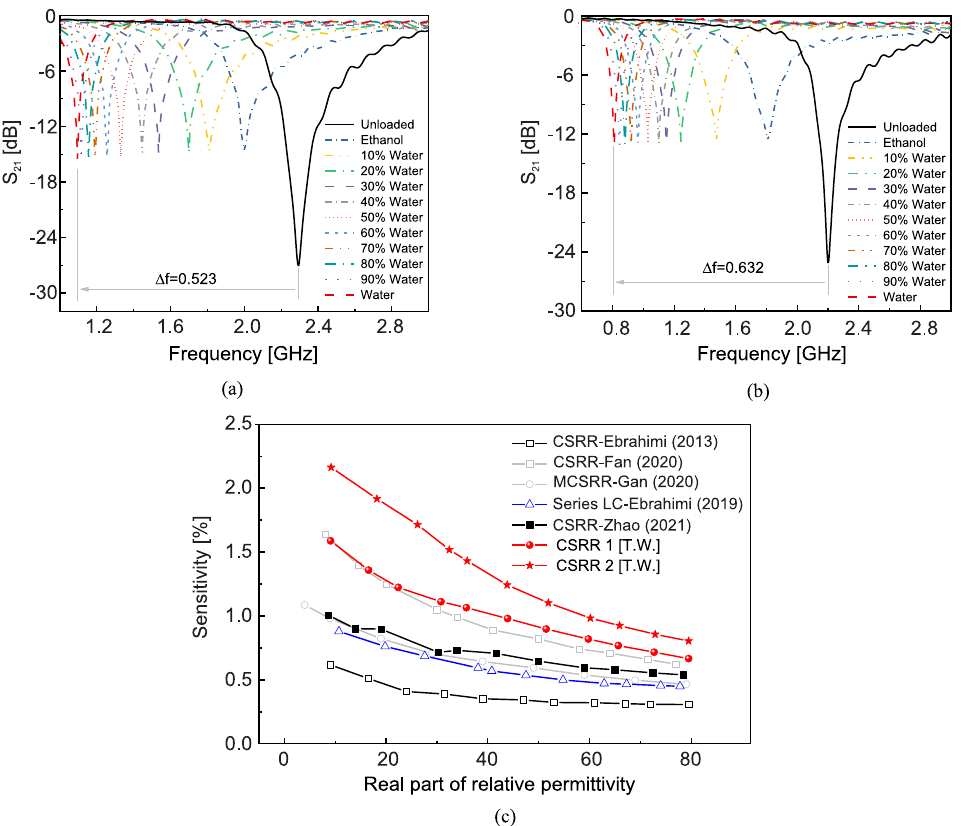
Figure 27. The transmission response of the optimized sensors: ( a ) the one optimized to minimize the volume of the liquid sample and ( b ) the one optimized with a fixed volume of sample under test. ( c ) Comparison between the sensitivity of the sensors fabricated in [85] and some other CSRR-based sensors as follows: Ebrahimi (2013) [65], Fan (2020) [93], Gan (2020) [94], Ebrahimi (2019) [21], Zhao (2021) [95]. Reprinted with permission from Ref.